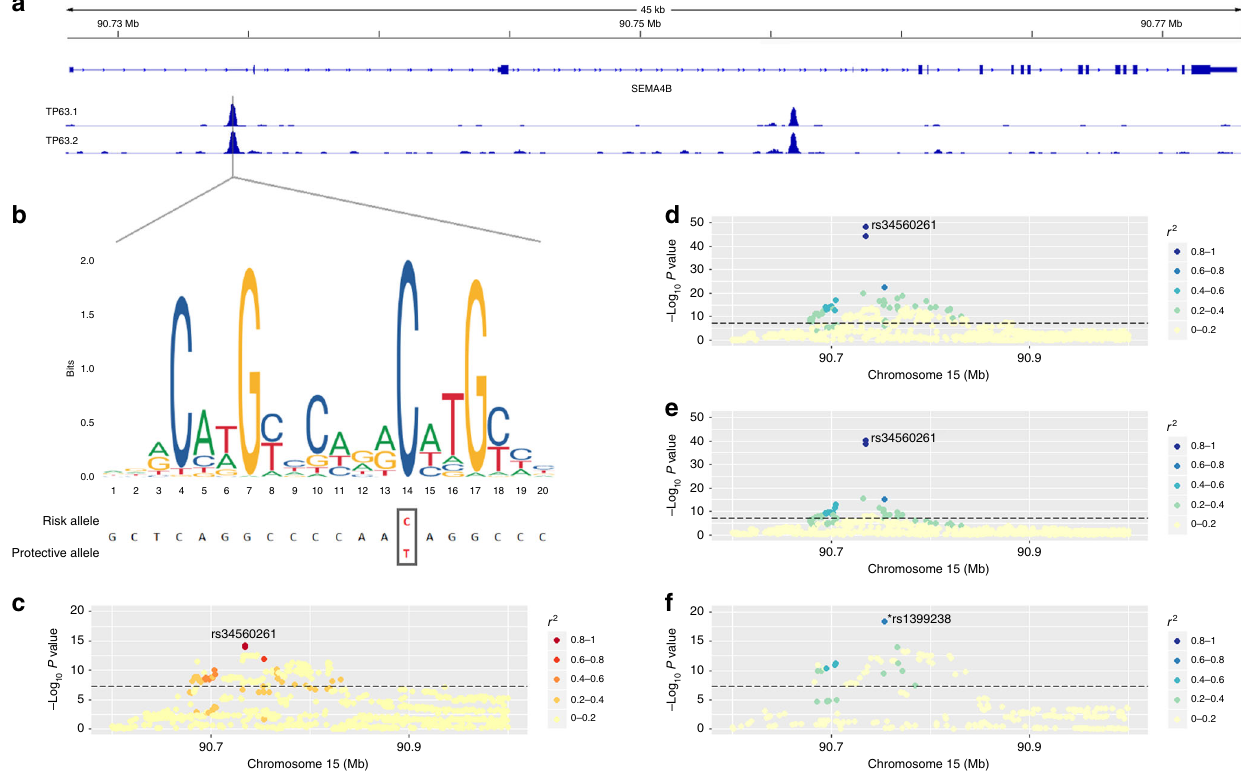
Fig. 2 Acne association signal at the 15q26.1 locus ( SEMA4B ). a ChIP-Seq read signal intensities of TP63 binding on two samples from human neonatal foreskin keratinocytes. b Sequence logo of the TP63- binding motif highlighting the risk and protective alleles for rs34560261. The invariant cytosine (position 14) is substituted by a thymine. c Regional acne association plot, variants are coloured according to the degree of LD ( r 2 ) with the lead SNP (rs34560261). d SEMA4B not sun exposed skin eQTL from GTEx. e SEMA4B sun exposed skin eQTL from GTEx. f SEMA4B skin eQTL from MuTHER study; * rs1399238 in LD with rs34560261 ( r 2 = 0.66) (rs34560261 was not present in the MuTHER